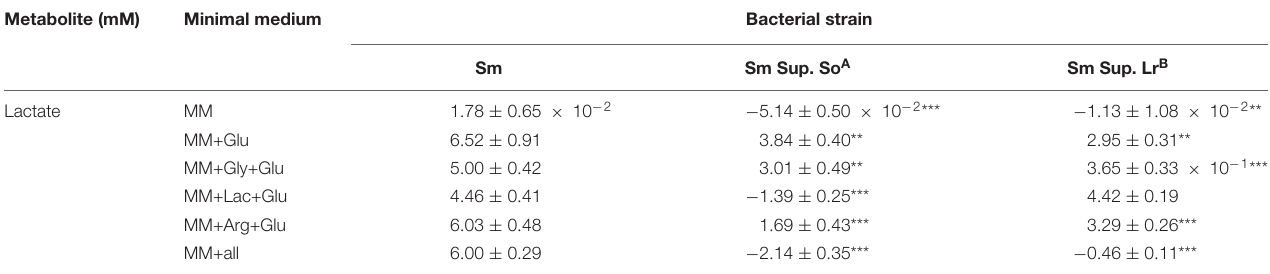
TABLE 1 | Changes (means ± standard deviations, n = 3/group) in lactate concentration (mM) of S. mutans (Sm) after cultivation in the supernatant (Sup.) of S. oligofermentans (So) and L. reuteri (Lr). Metabolite